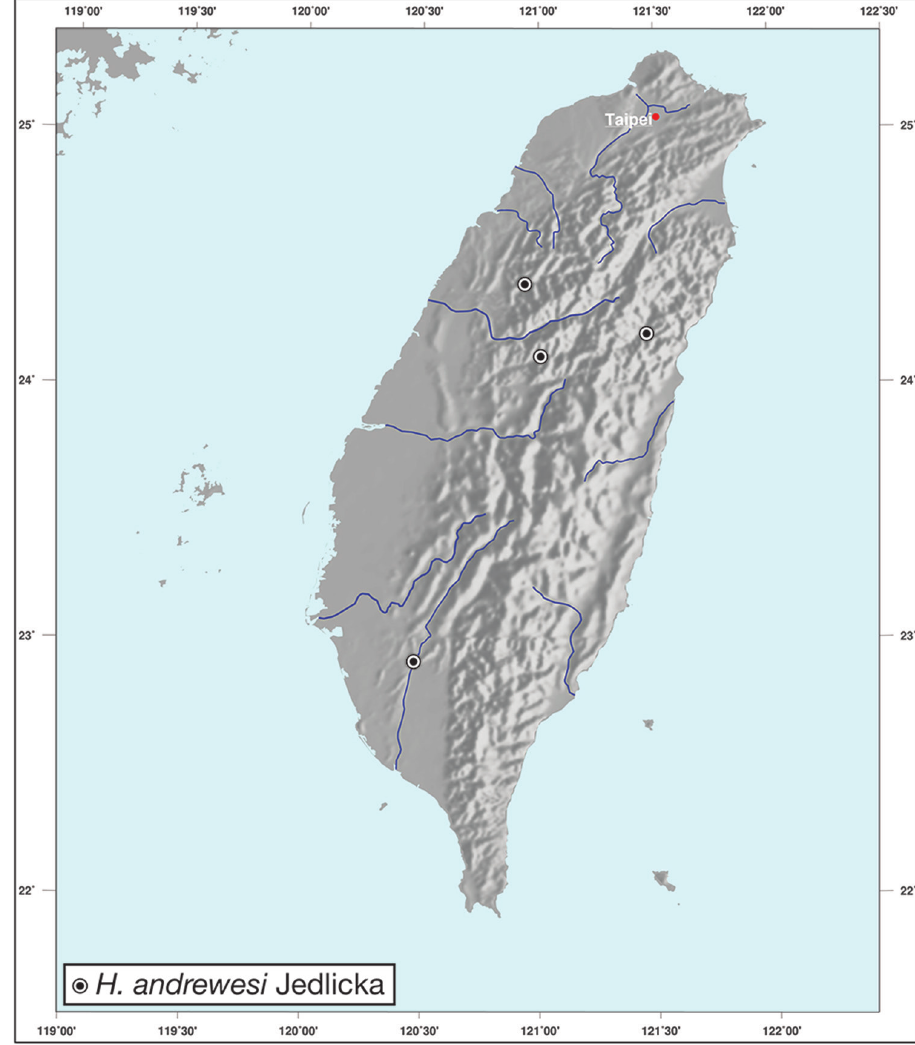
Figure 85. Map showing known localities for species of the genus Horniulus Jedlička, in